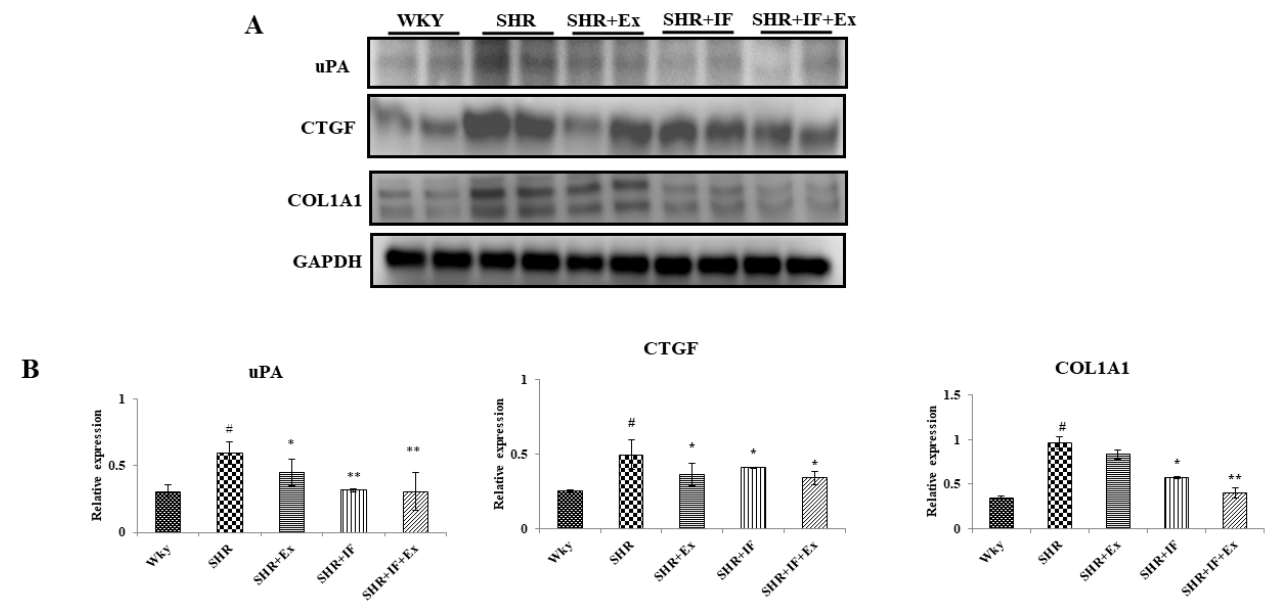
Figure 5. Effects of IF peptide and swimming exercise in cardiac fibrosis pathway. ( A ) Expression of uPA, urokinase-type plasminogen activator protein; CTGF, connective tissue growth factor; COL1A1, collagen type I α 1 chain. ( B ) Densitometric analysis of relative protein expression, nor- malized with internal control GAPDH. n = 8, # p < 0.01 compared to WKY, * p < 0.05, and ** p < 0.01 compared to